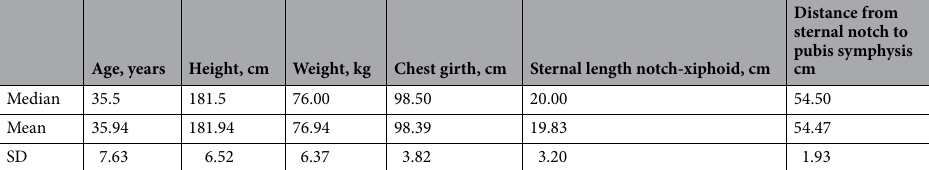
Table 1. Morphological characteristics of the subjects. Values for individual subjects are available in “Supplementary Information” files.